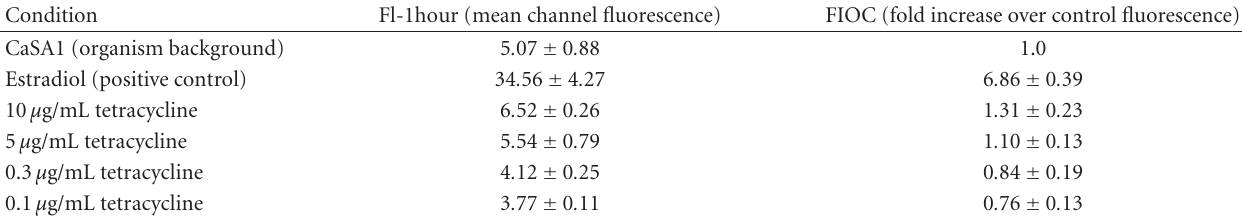
Table 2: Flow cytometry evaluation of CDR1 expression in response tetracycline exposure.